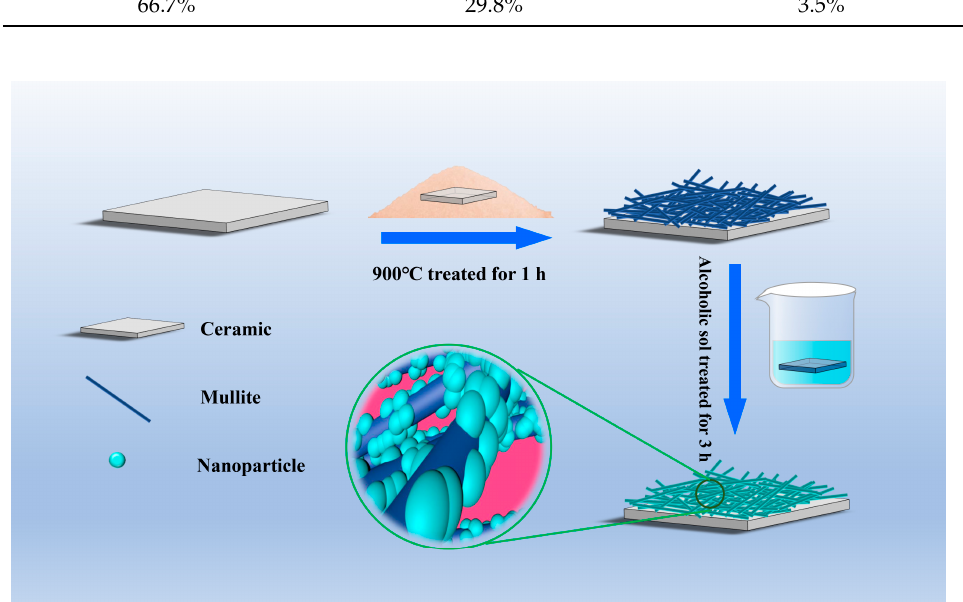
Figure 2. Superhydrophobic ceramic surface preparation process.